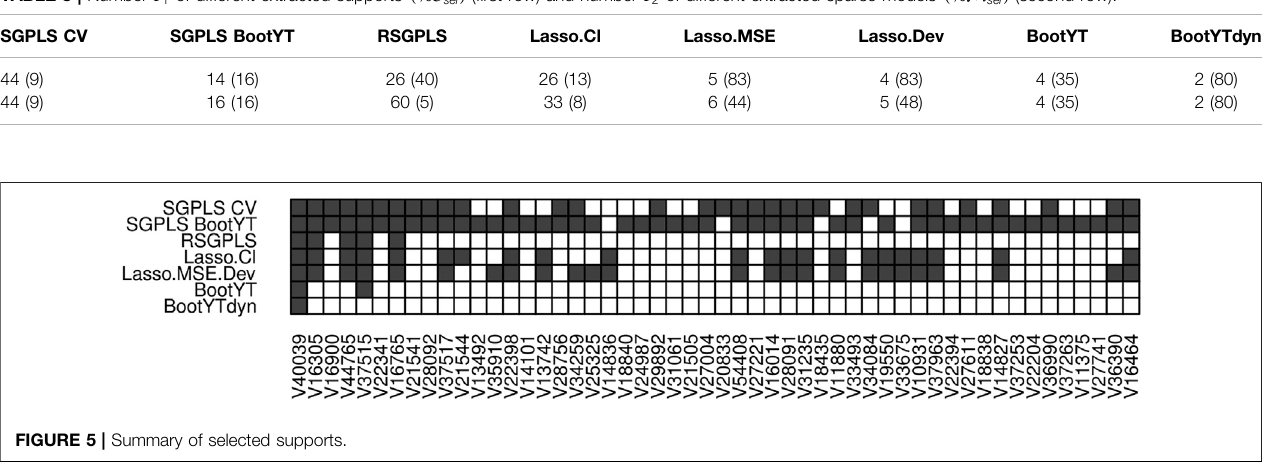
TABLE 8 | Number Γ 1 of different extracted supports ( % S sel ) ( fi rst row) and number Γ 2 of different extracted sparse models ( % M sel ) (second row).